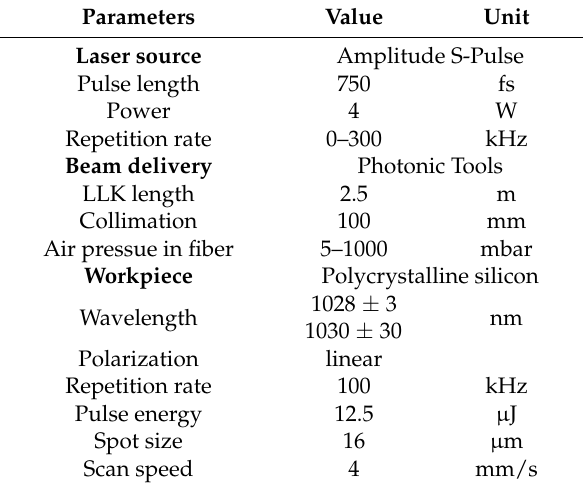
Table 2. Processing parameters of silicon surface